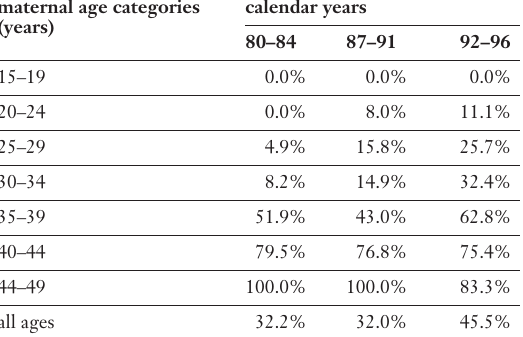
Number of births ob- served with trisomy 21 for the years 1980–1996 in the maternal age cate- gories “all ages”,